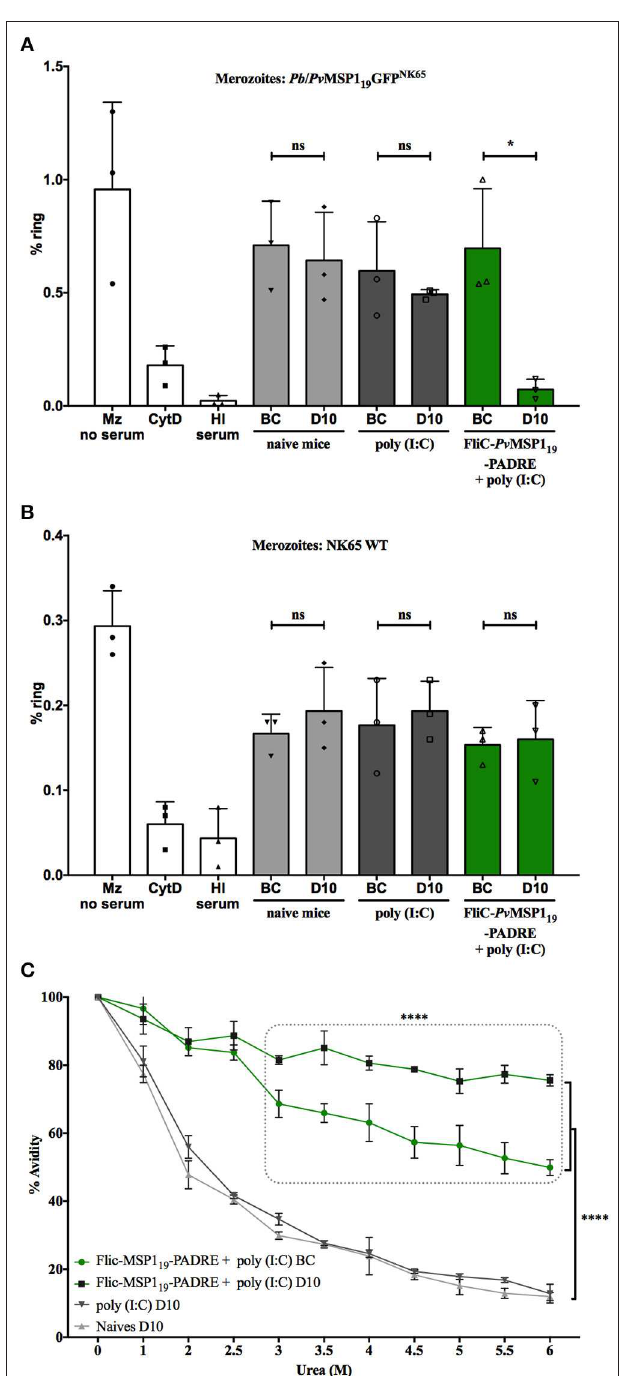
FIGURE 10 | Sera from mice immunized with HIS 6 -FliC- Pv MSP1 19 -PADRE + poly (I:C) and challenged inhibit merozoite invasion and has increased antibody affinity to Pv MSP1 19 . Inhibition of Pb/Pv MSP1 19 GFP NK65 merozoites (A) or NK65 wild type (WT) merozoites (B) invasion of erythrocytes in vitro with pooled sera taken from naïve or poly (I:C) control mice, or from mice immunized with HIS 6 -FliC- Pv MSP1 19 -PADRE + poly (I:C) before challenge (BC) and at day 10 (D10) post-challenge with Pb/Pv MSP1 19 GFP NK65 . Controls are assays with merozoites and erythrocytes with no added